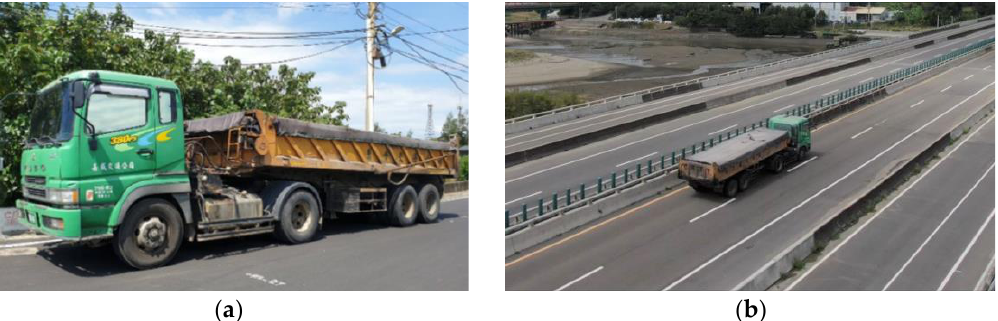
Figure 16. Vehicle loading test: ( a ) image of the vehicle, which weighed 38.46 metric tons, and ( b ) photo of the vehicle when it moved on the bridge.